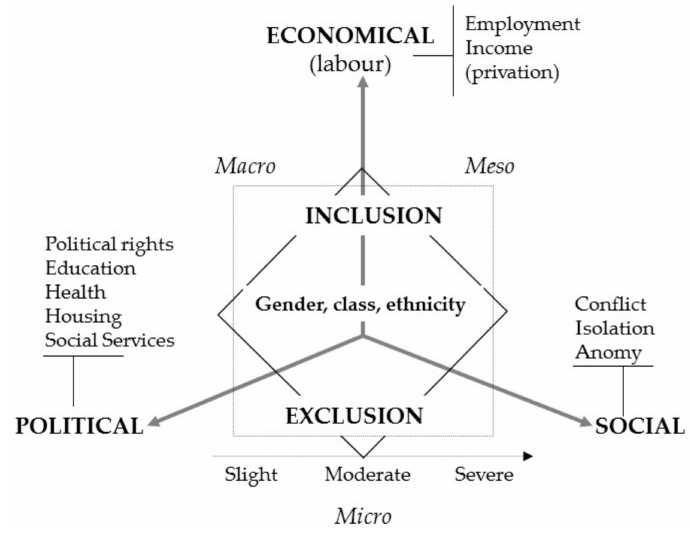
Figure 1. Axes and aspects of social exclusion. Source: [14] (p.